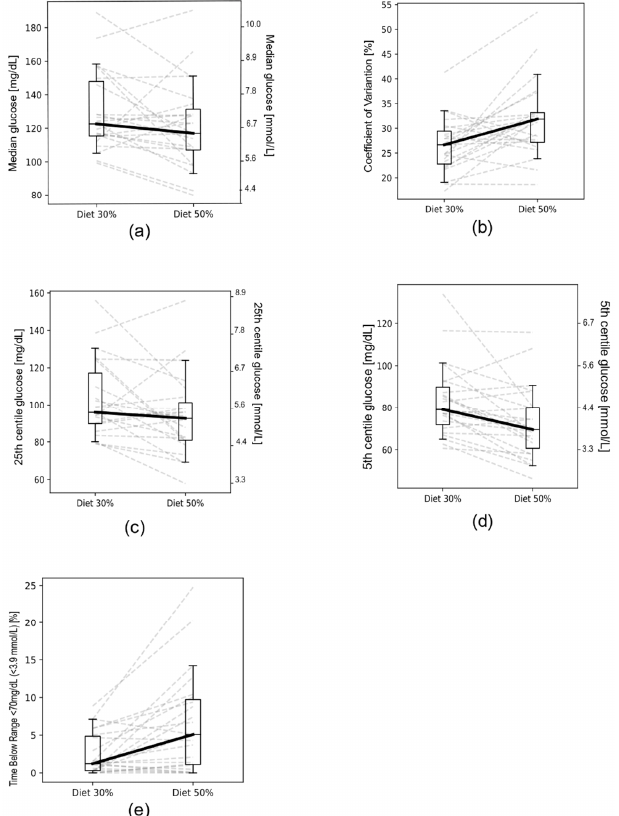
Figure 2. Comparison between particular glycaemic variables for 30% and 50% diets: ( a ) median; ( b ) coefficient of variation (%); ( c ) 25th cent.; ( d ) 5th cent.; ( e ) time below range 70 mg/dL (<3.9 mmol/L). Dashed lines represent parameter changes between diets, as specified per individual pa- tients.